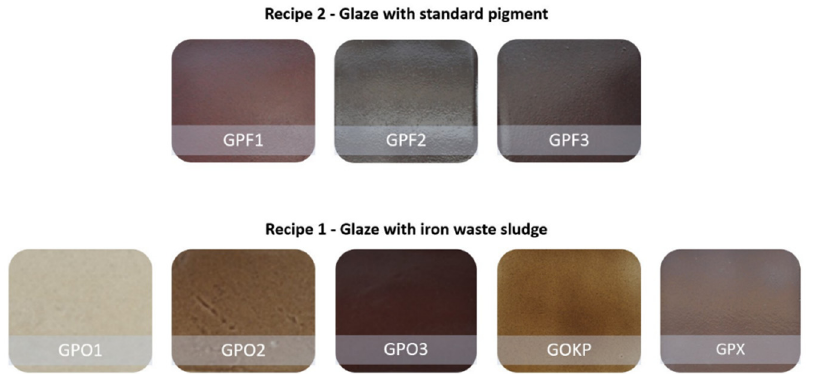
Figure 10. Images of final colored glazes prepared with the following recipe type: Recipe 2 = GPF1, 2, 3 (10 wt.% SP1, 2, 3 + 90 wt.% TG); Recipe 1 = GPO1 (1 wt.% WFS/180 + 99 wt.% TG); GPO2 (5 wt.% WFS/180 + 95 wt.% TG); GPO3 (10 wt.% WFS/180 + 90 wt.% TG); GOKP (10 wt.% WFS/0 + 90 wt.% TG); and GPX (10 wt.% WFS/900 + 90 wt.%